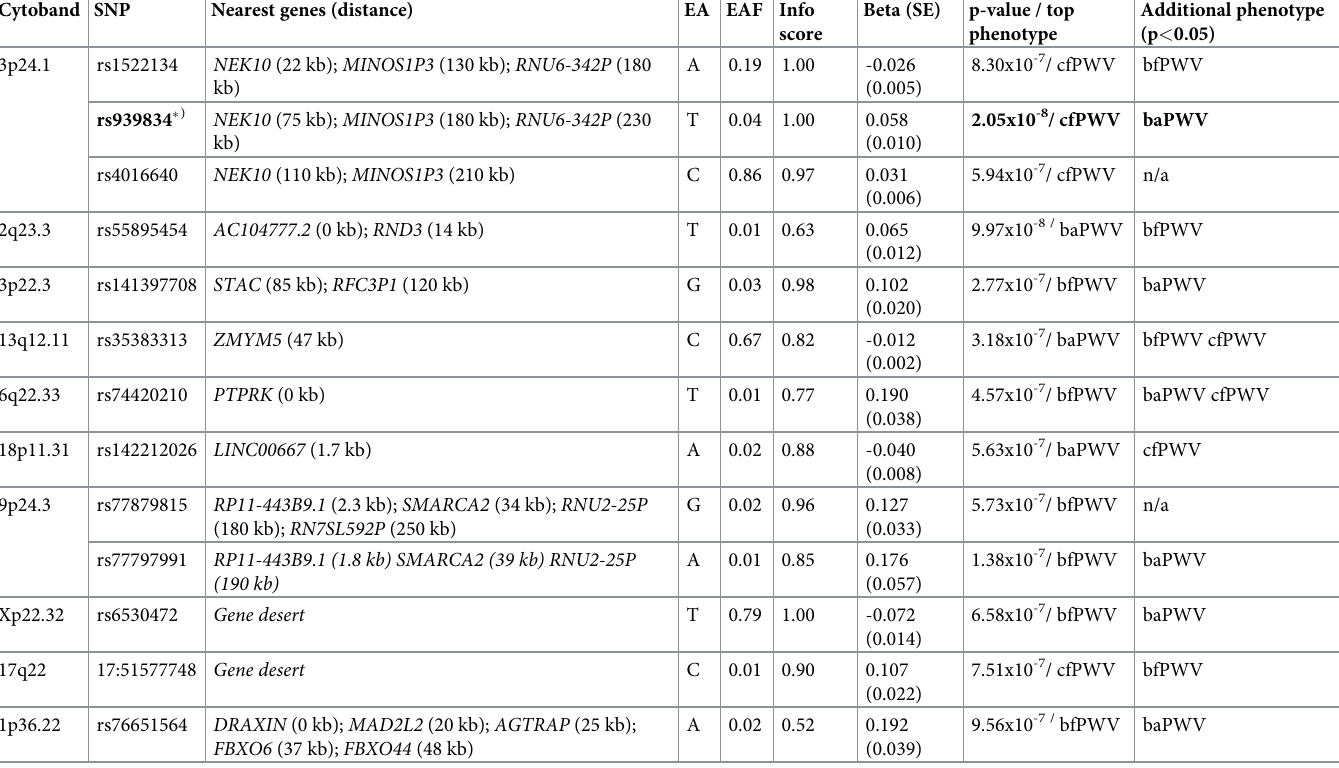
Table 3. Summary statistics of 10 loci reaching at least suggestive significance for any of the PWV modes. Cytoband SNP Nearest genes (distance) EA EAF Info